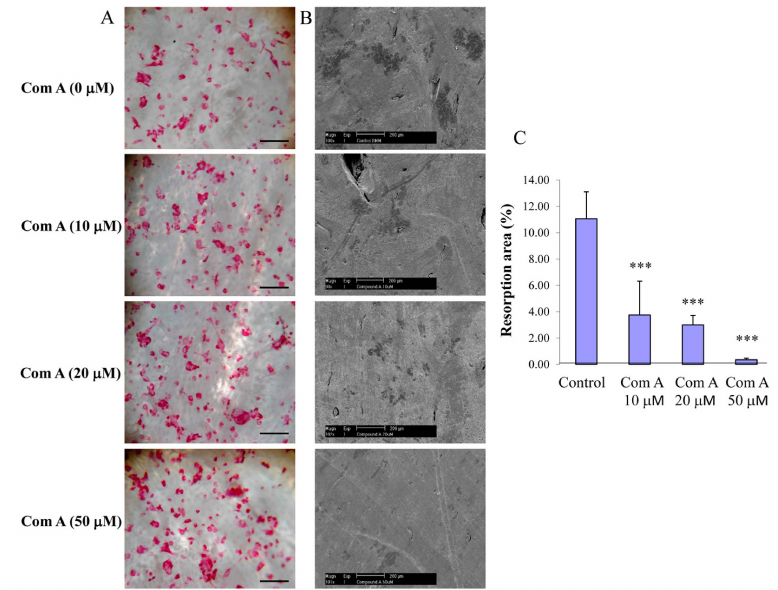
Figure 4. Inhibition of bone resorption by compound A. Preformed BMM derived osteoclasts were seeded on bone slices in the presence and absence of compound A for 48 h at 37 ˝ C to initiate bone resorption. ( A ) Representative images showing TRACP positive OCL cells present in the surface of bone slice; (Mag = 20 ˆ , scale bar = 100 µ m); ( B ) Representative SEM images of bone resorption (Mag = 10 ˆ , scale bar = 200 µ m); and ( C ) resorption area expressed as total bone area normalized with osteoclast numbers (*** p < 0.001 compared to control, n = 3).